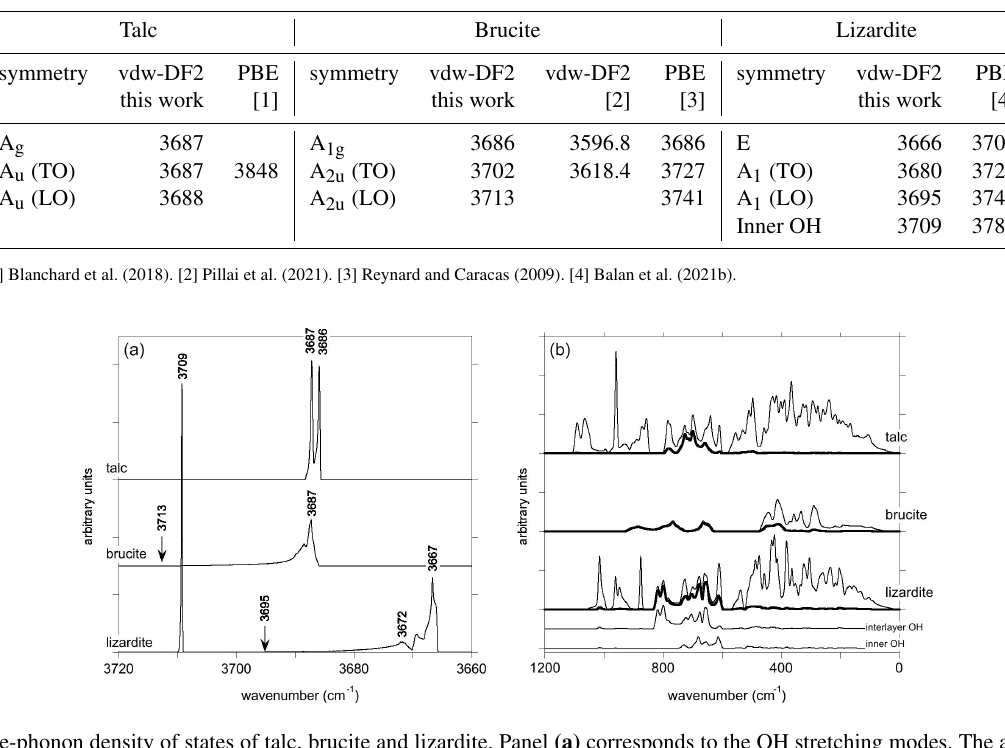
Figure 4. One-phonon density of states of talc, brucite and lizardite. Panel (a) corresponds to the OH stretching modes. The arrows point to the LO frequency of A 2u and A 1 interlayer OH stretching modes in brucite and lizardite, respectively. The thick line in (b) corresponds to the contribution of H displacements. For lizardite, the contributions of inner and interlayer OH groups are reported below. Note that a smaller smearing has been used to obtain the DOS of OH stretching modes (a)